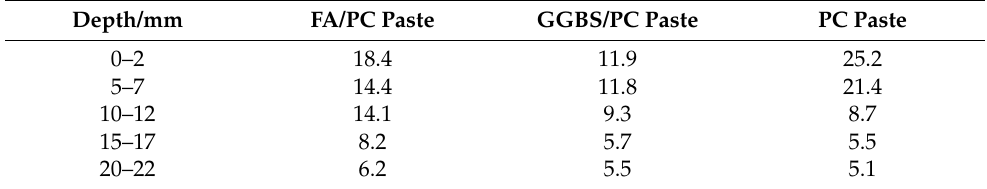
Table 4. Summary of the calcium carbonate content (%) at five depths of carbonated FA/PC, GGBS/PC and PC paste samples under a thermogravimetry (TG) analysis. Depth/mm FA/PC Paste GGBS/PC Paste PC